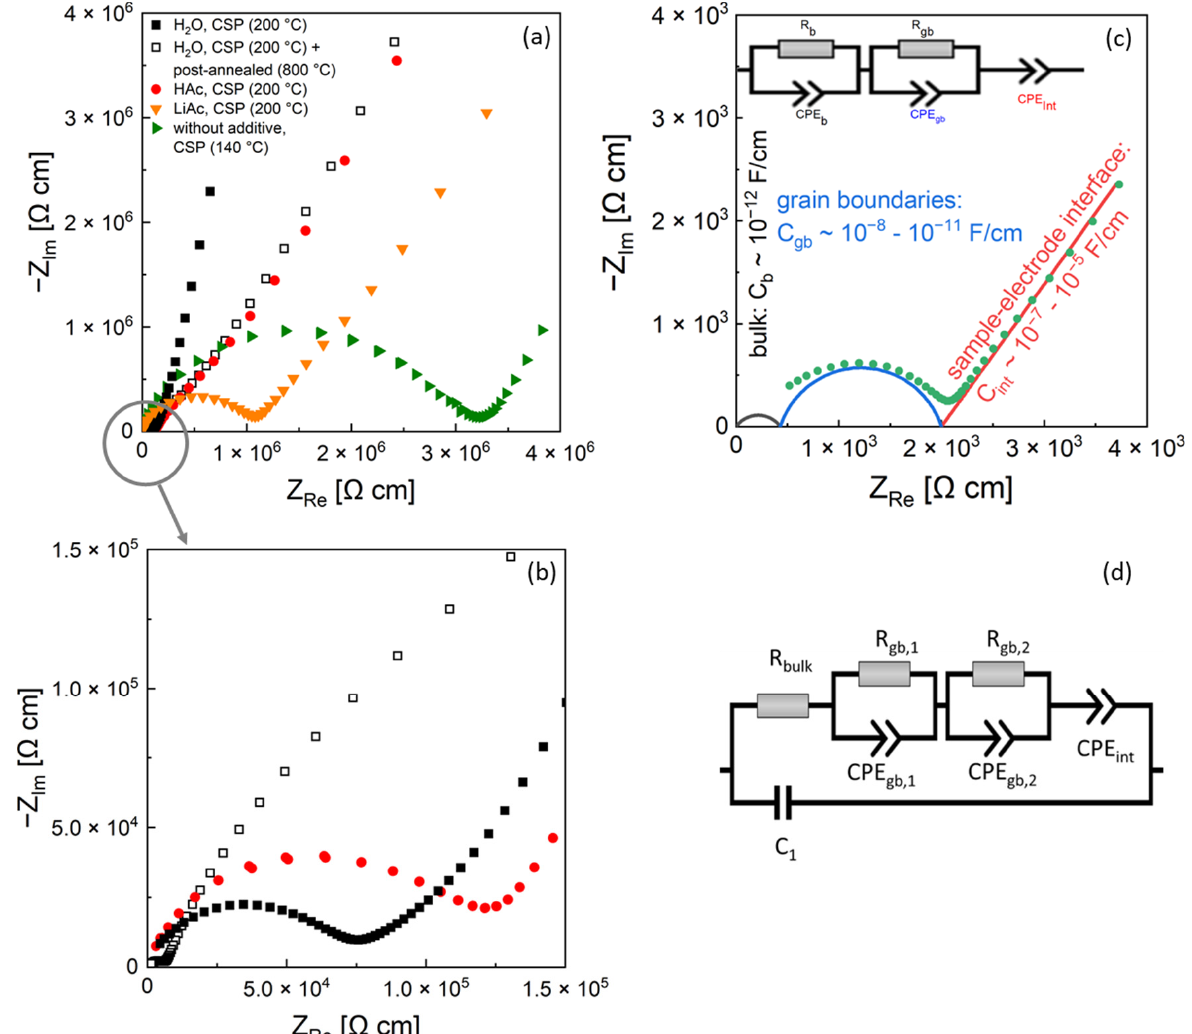
Figure 3. EIS spectra of cold-sintered LATP samples ( a , b ) and typical electrical equivalent circuit ( c ) used in literature [16] for interpretation of impedance data of ionic conducting samples with schematical illustration of the corresponding semicircles for bulk and grain boundary conductivity and straight line for blocking electrode polarization. Equivalent circuit ( d ) used in present work for fitting of EIS spectra of cold-sintered LATP samples. The EIS measurements were performed at 25 ◦